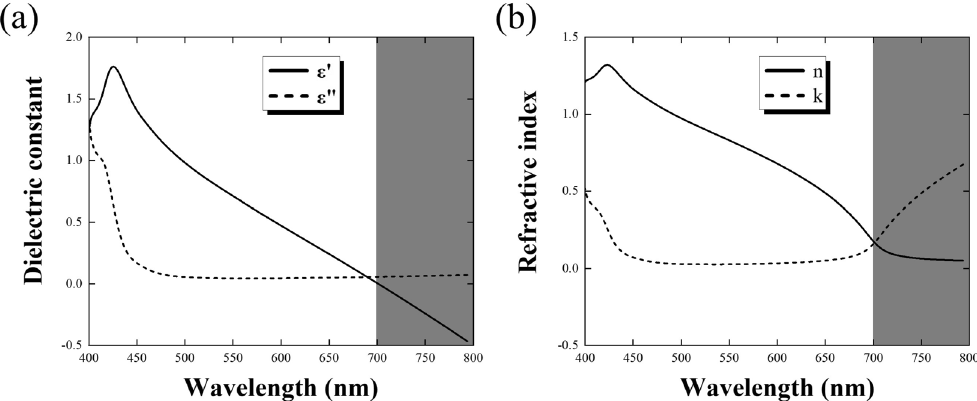
Figure 4. Retrieved ( a ) permittivity and ( b ) refractive index of the proposed Ag NPWs. The effective plasmon frequency is lower down to at a wavelength of 700 nm, confirming our proposed mechanism. Also, the effective refractive index within this frequency range is much lower than the one of ITOs, thus improving the output efficiency of optical devices.